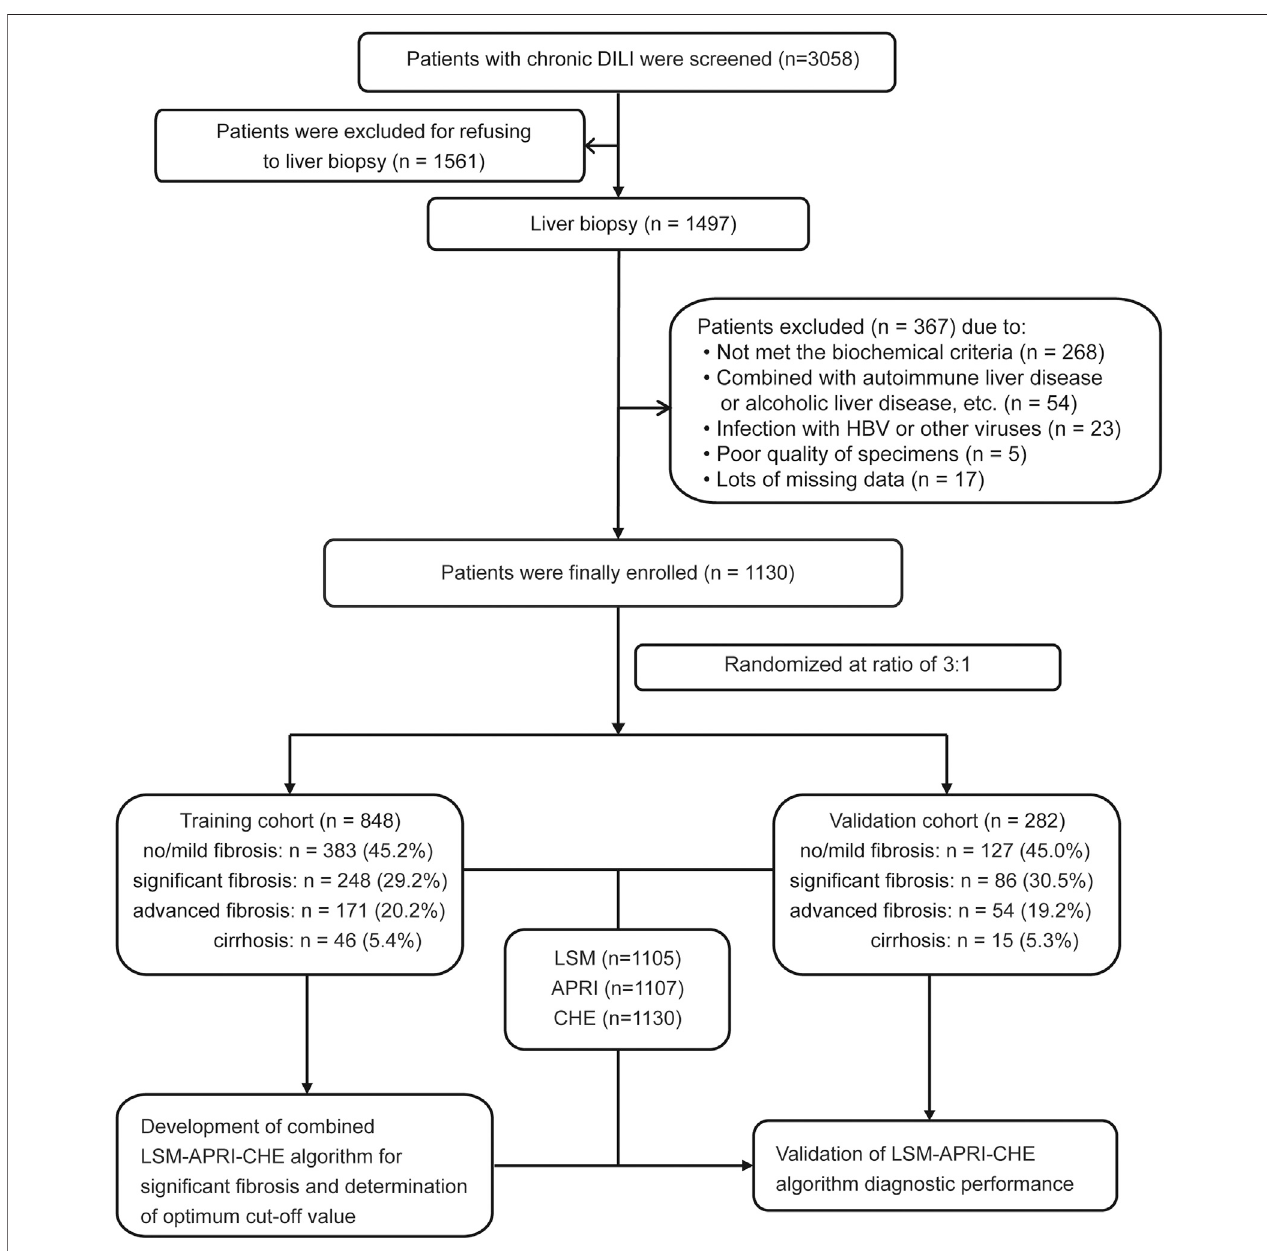
FIGURE 1 | Flow chart of study